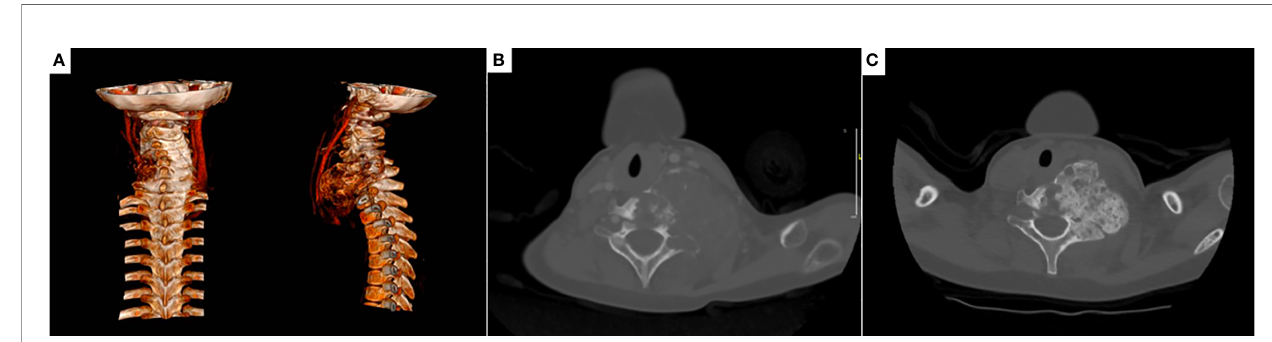
FIGURE 1 | Aneurysmal bone cyst at diagnosis. MRI with 3D reconstruction at diagnosis (A) showing the calci fi ed lytic lesion originating from C4-C7 hemivertebrae and encaging the vertebral artery, preventing invasive surgery; CT at diagnosis (B) identi fi ed a bulky lesion originating from C4-C7 hemivertebrae. CT performed 6 months after the introduction of denosumab (C) showed a massive calci fi cation of the lesion that remained stable